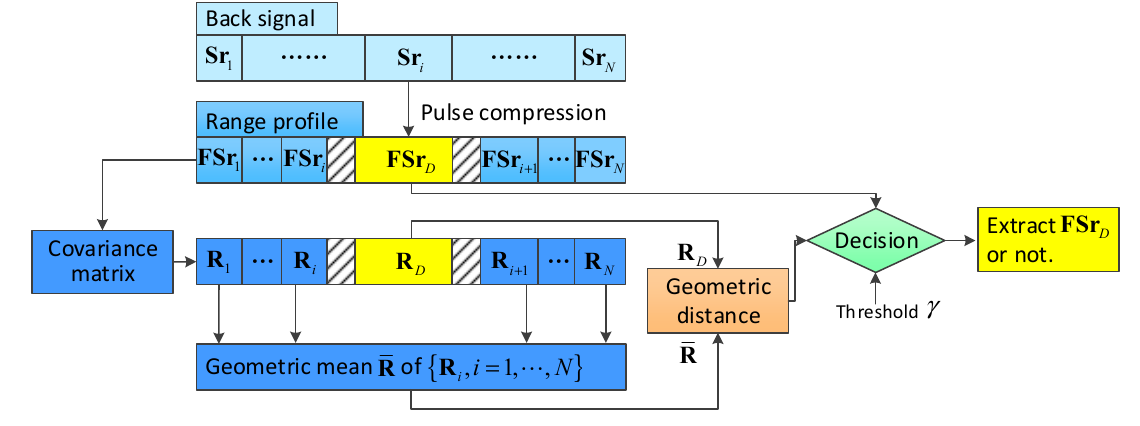
Figure 2. Range profile extraction based on geometric measures (GMs).